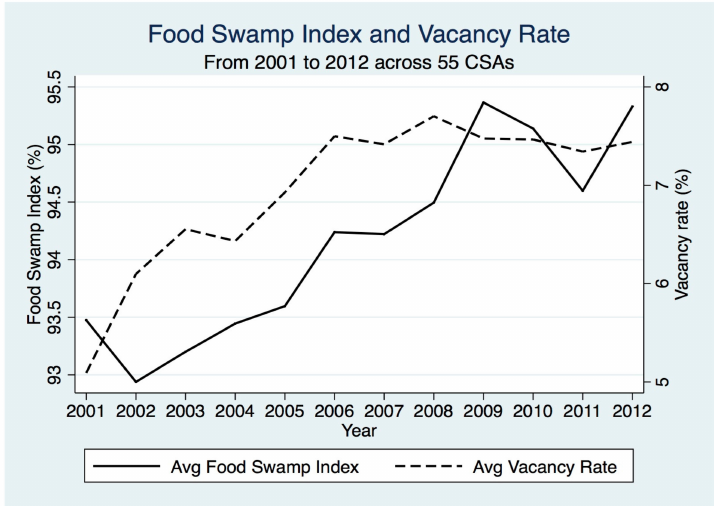
Figure 3. Average food swamp index and average vacancy rate across 55 CSAs in Baltimore, MD, USA, over the study period from 2001 to